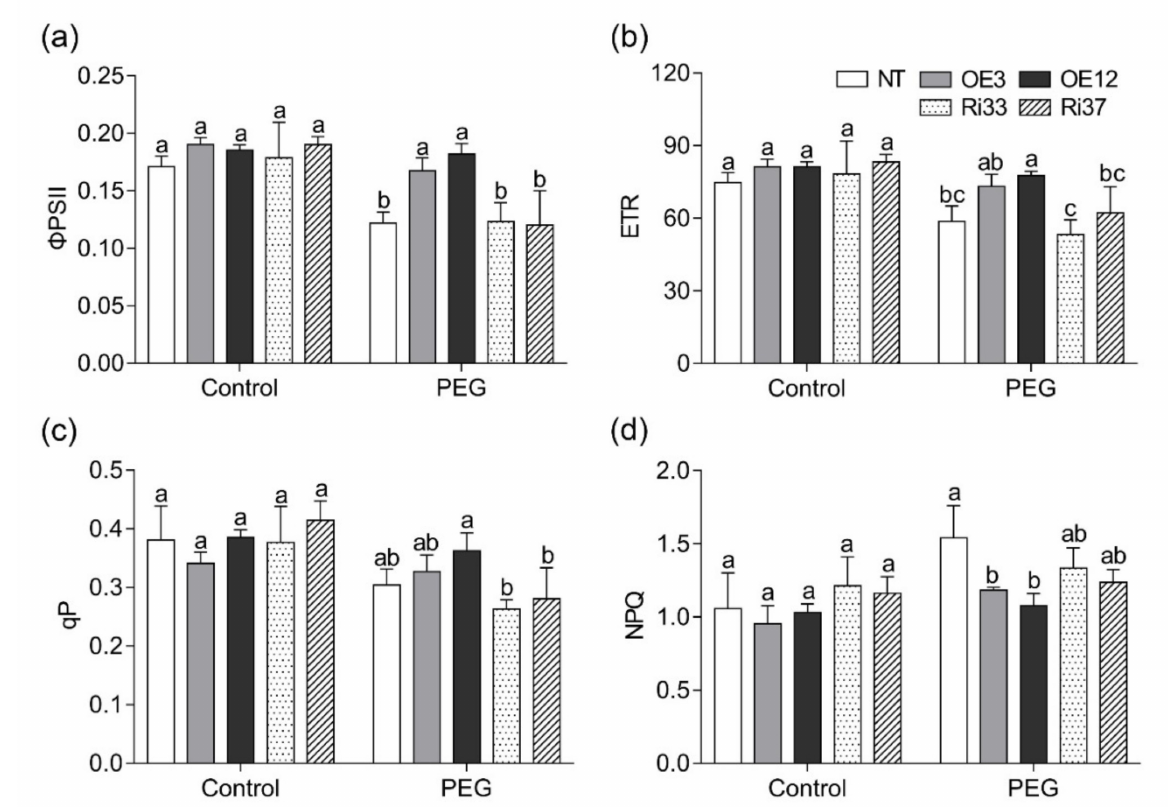
Figure 3. Effects of CgbHLH001 overexpression on chlorophyll fluorescence parameters of maize seedlings under drought stress. ( a ) Effective PSII quantum yield ( Φ PSII); ( b ) electron transport rate (ETR); ( c ) photochemical quenching (qP); ( d ) non-photochemical quenching (NPQ). NT, non- transgenic plant; OE3 and OE12, CgbHLH001 -overexpressed T 3 maize lines; Ri33 and Ri37, ZmbHLH - RNAi T 3 maize lines. PEG, 15% PEG 6000. Different lowercase letters above the columns indicate significant differences between NT plants and transgenic lines under the same condition (Tukey’s test, p < 0.05). Values are means ± SD of three